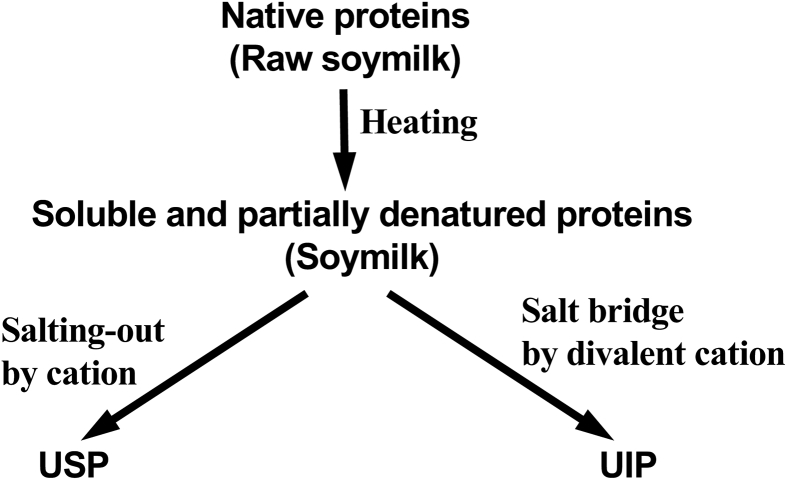
Schematic depiction of the formation of USPs and UIPs. The arrows from native proteins to soluble and partially denatured proteins indicate the production of soymilk from raw soymilk by heating at 100 °C, according to the models from Kohyama et al., 1995, Ono et al., 1991; and Shun-Tang et al. (1997).